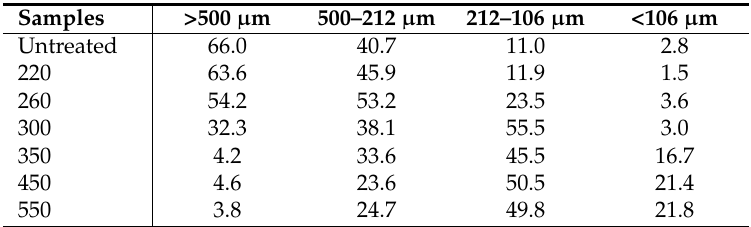
Table 3. Particle size distribution of the milled untreated and treated